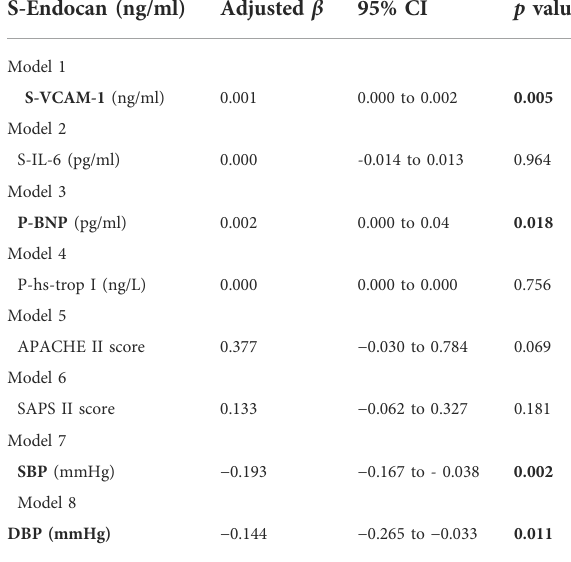
TABLE 2 Repeated measures multivariate models for S-Endocan in AHF and CS patients. (Adjusted β ), 95% con fi dence intervals (95% CI) and p value estimated by repeated measures multivariate models with S-Endocan as the dependent variable and adjusted for age and